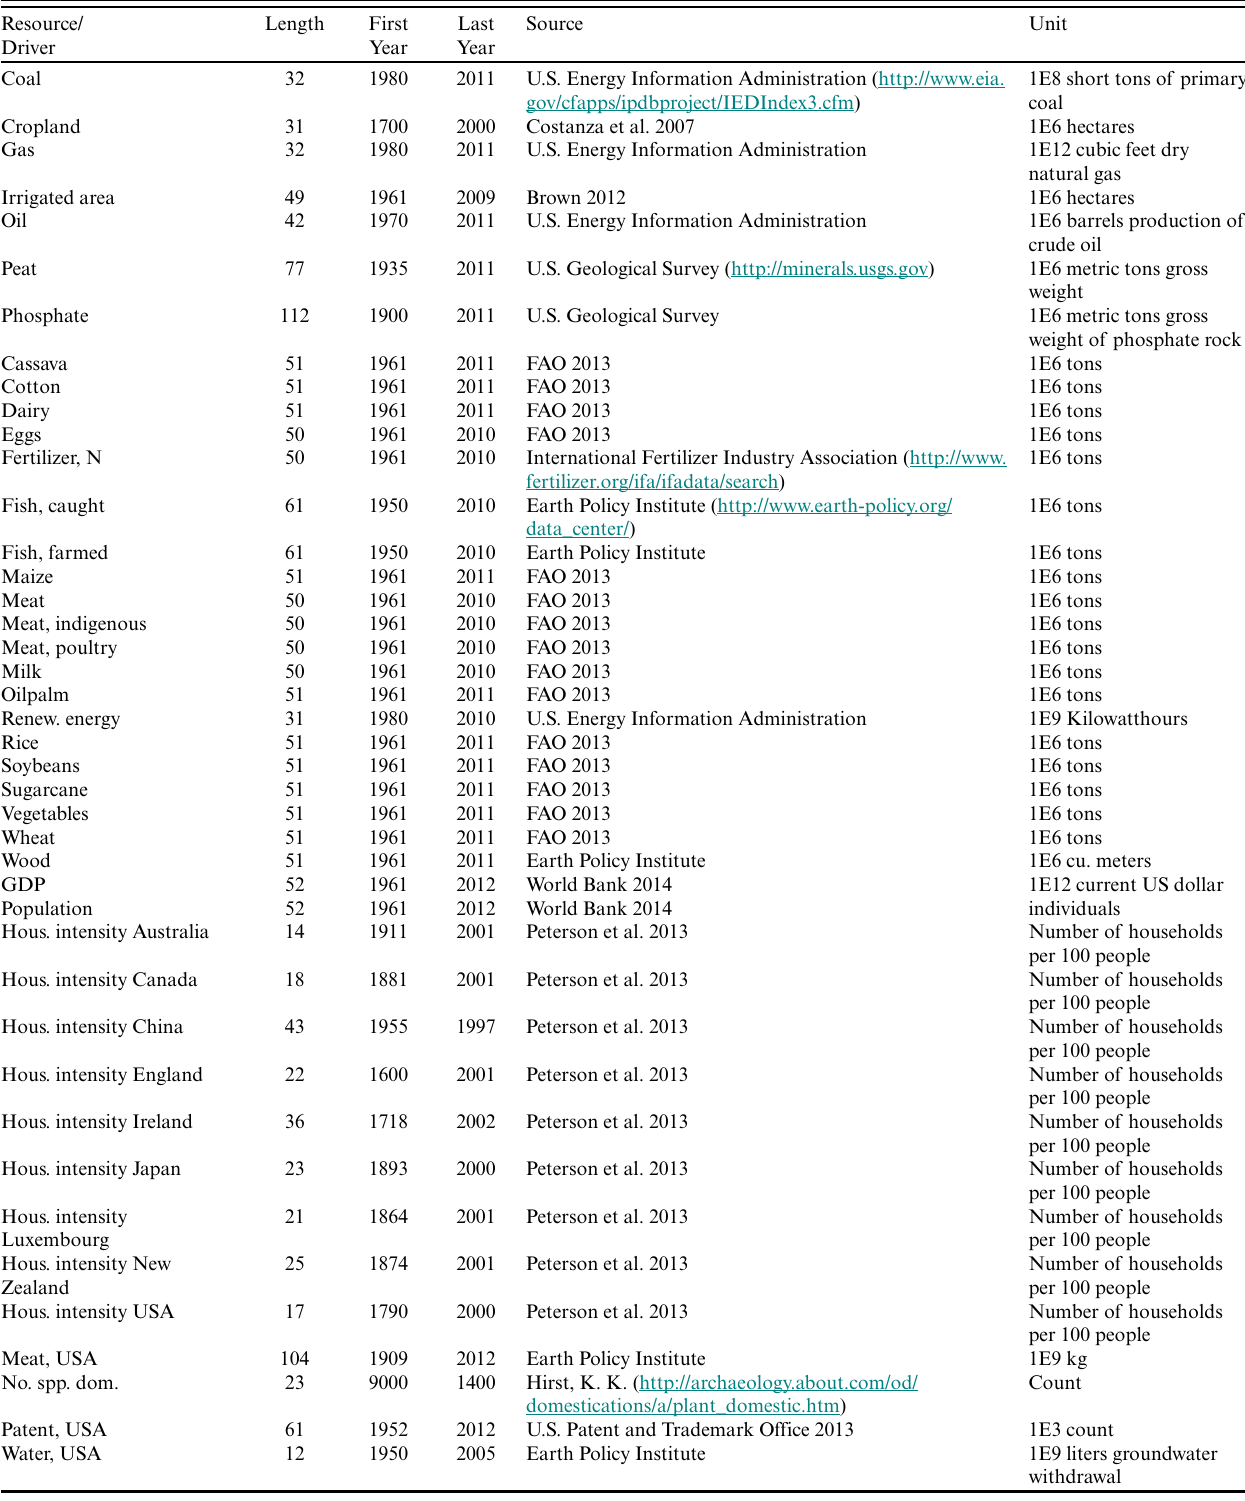
Table 2 . List of time series and data sources. Internet resources accessed on